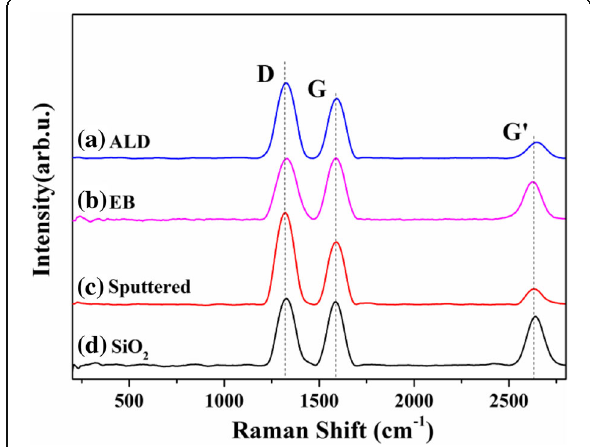
Fig. 1 Raman spectra of VACNTs grown on different buffer layers: